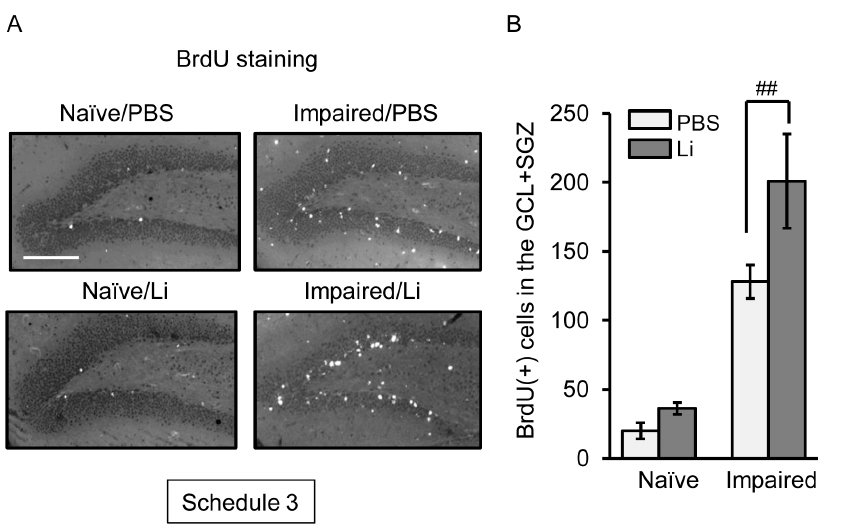
Figure 4. Effect of lithium (Li) on the survival of BrdU( + ) cells generated following neuronal loss. Animals were given either lithium carbonate (100 mg/kg, i.p.) or PBS with BrdU on day 2 post-treatment with PBS or TMT, subsequently given either lithium carbonate or PBS up to day 15, and then decapitated on day 30 post-treatment for preparation of sagittal hippocampal sections, which were then stained with anti-BrdU antibody (Schedule 3). ( a ) Fluorescence micrographs show BrdU( + ) cells in the dentate gyrus of the 4 groups (naı¨ve/PBS, naı¨ve/Li, impaired/PBS, impaired/Li). Scale bar=100 m m ( b ) Graph showing the number of BrdU( + ) cells in the GCL + SGZ of the 4 groups. Values are expressed as the mean 6 S.E., calculated from 5 animals. ## P , 0.01, significant difference between the values obtained for PBS and Li groups.